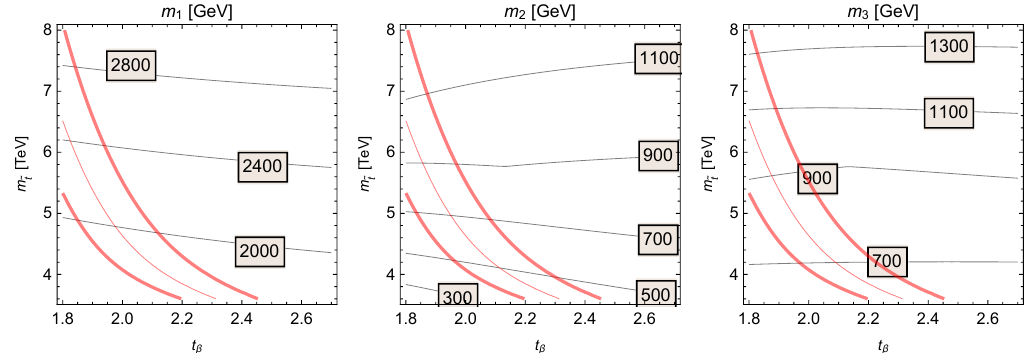
Figure 12 . The mass spectrum of the scalars for the numerical benchmark illustrated in this section. m 1 is dominantly from the scalars on the H side of the tower. Notice the level-crossing between m 2 and m 3 in the 900 GeV contour; one of these eigenvalues is mostly comprised of h b , while the other one is mainly made of the H (cid:12)elds.